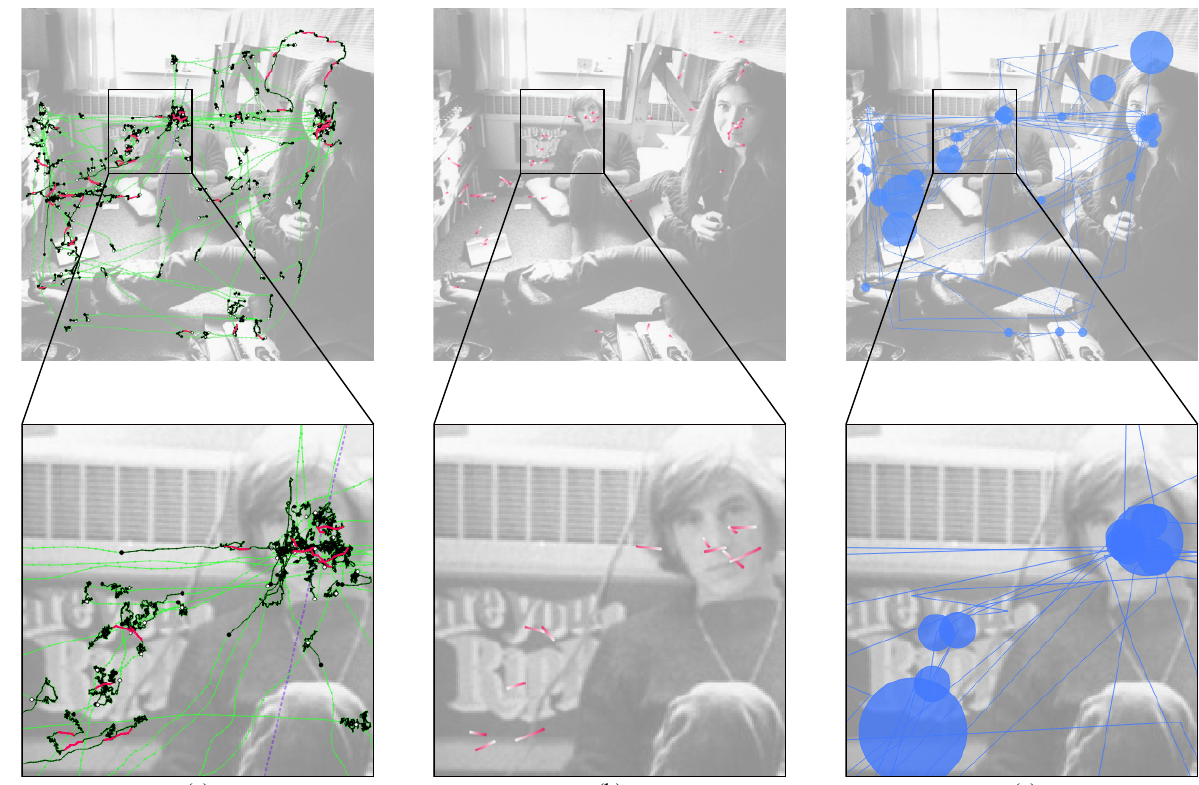
Figure 2. Different aspects of the eye tracking data can be visualized in the stimulus view. (a) Connected raw samples (green), connected fixation samples (black), connected microsaccade samples (pink), and missing data range (purple). (b) Directional microsaccade lines: pink for start sample, white for end sample. (c) Scanpath (blue) with fixations represented by circles (their size is in relation to the number of microsaccades within them) and saccades by